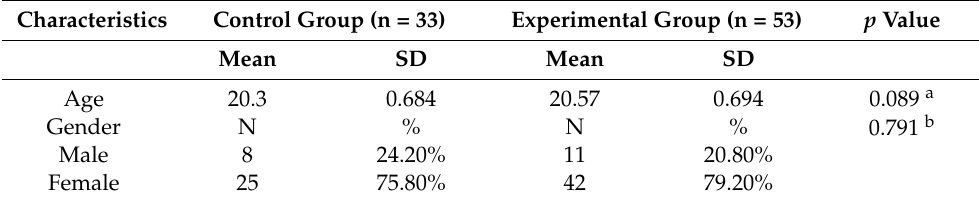
Table 1. Characteristics of participants.